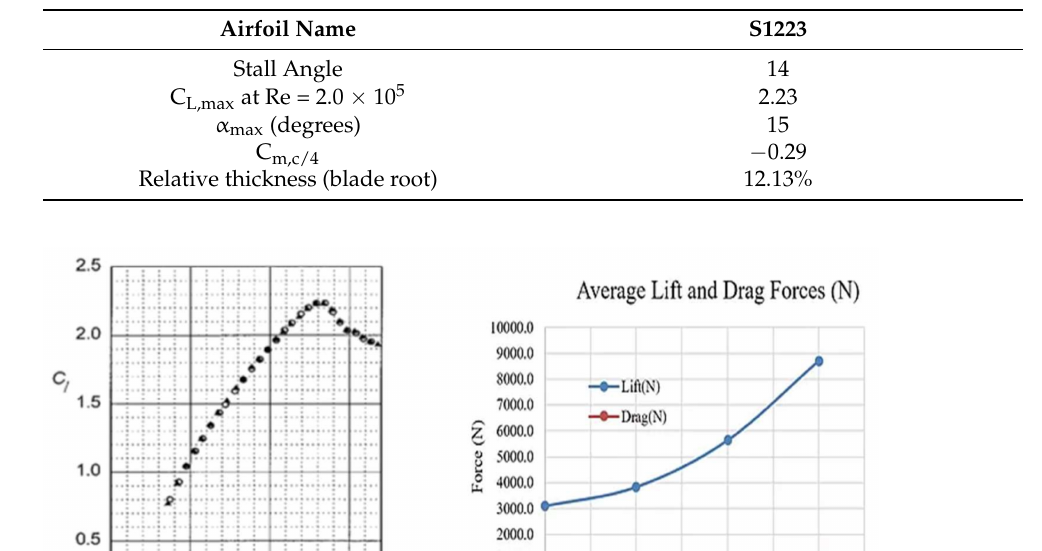
Table 1. Aerodynamic properties and the CFD results from analysis of the S1223 airfoil profile. Adapted from [16,17].